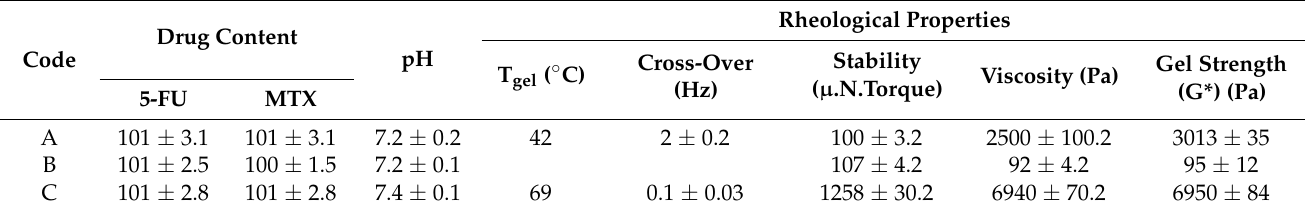
Table 2. The properties of different modified hydrogel